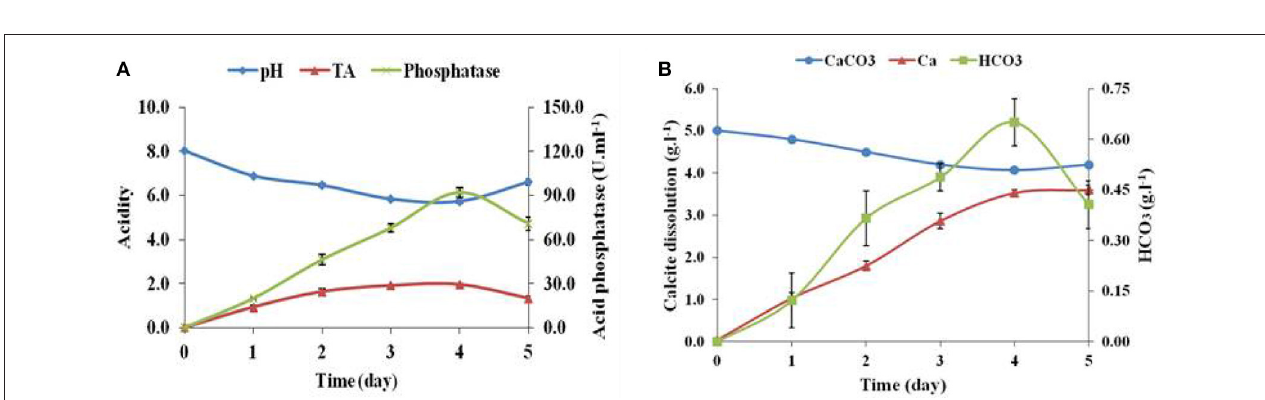
FIGURE 4 | Phylogeny of CDB isolates. The phylogenetic relationship of the selected isolates (SORI09, SOTI05, and SOTI06) and their related strains based on 16S rRNA sequence was constructed using Mega 6. Numbers at nodes indicate the level of bootstrap support (1000 replications). Scale bar indicates base substitutions/1000 bases.